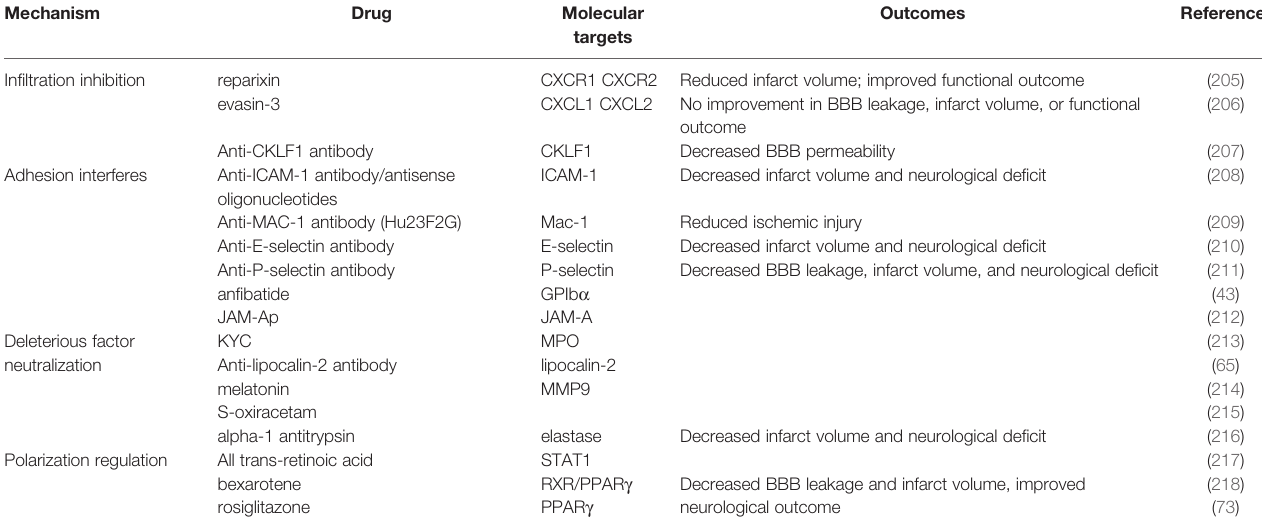
TABLE 1 | Preclinical attempts to target neutrophils for treating